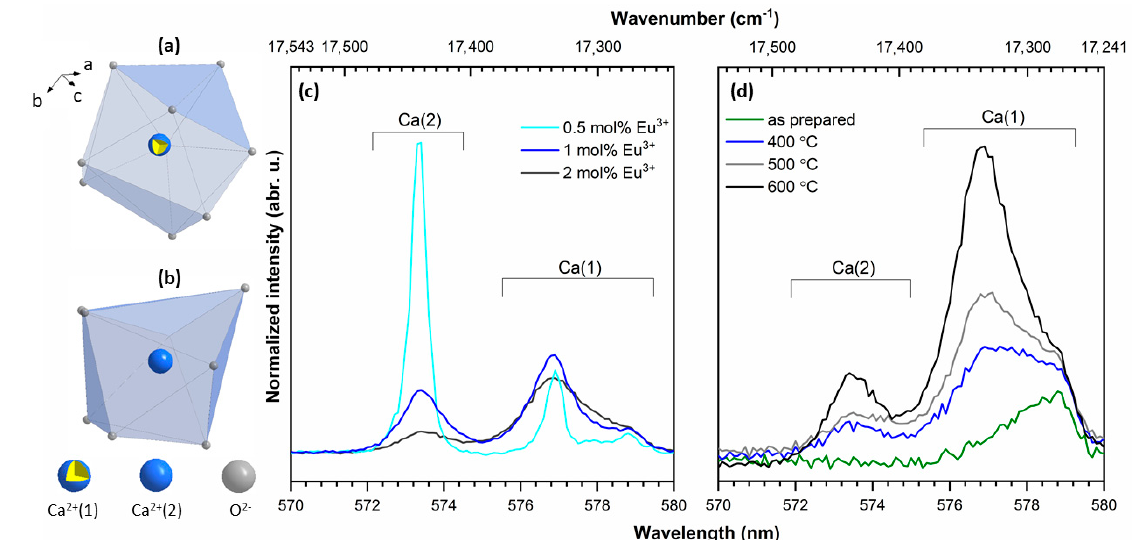
Figure 5. The projection of the coordination polyhedra of ( a ) Ca(1) and ( b ) Ca(2) cations, respectively. Emission spectra of ( c ) Ca 9.8-x Sr 0.2 Eu x (PO 4 ) 2 (SiO 4 ) 4 (OH) 2 , where x = 0.5, 1.0, 2.0 mol%, sintered at 600 °C and ( d ) Ca 9.6 Sr 0.2 Eu 0.2 (PO 4 ) 2 (SiO 4 ) 4 (OH) 2 as a function of sintering temperature, for the 5 D 0 → 7 F 0 transition.